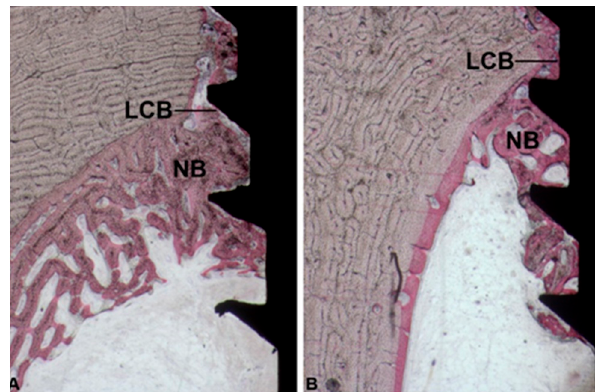
Figure 8. ( A , B ) Marrow portion. In the coronal portion new bone formation (NB) close to the implant surface was observed. It started from the pre-existing bone (LCB) and had grown on the implant surface in an apical direction. In the test group ( B ) more new bone formation (NB) was present. (Acid fuchsin-Toluidine blue 18X).